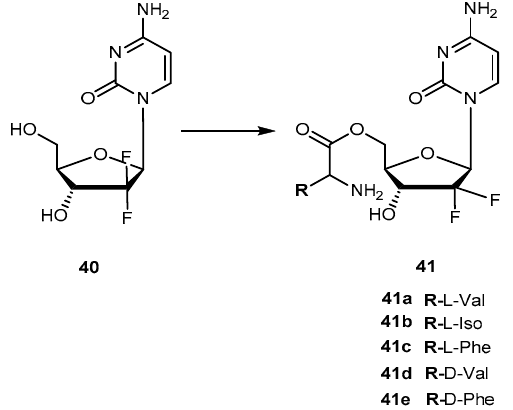
Figure 19. Structures of amino acid ester prodrugs of 40 .